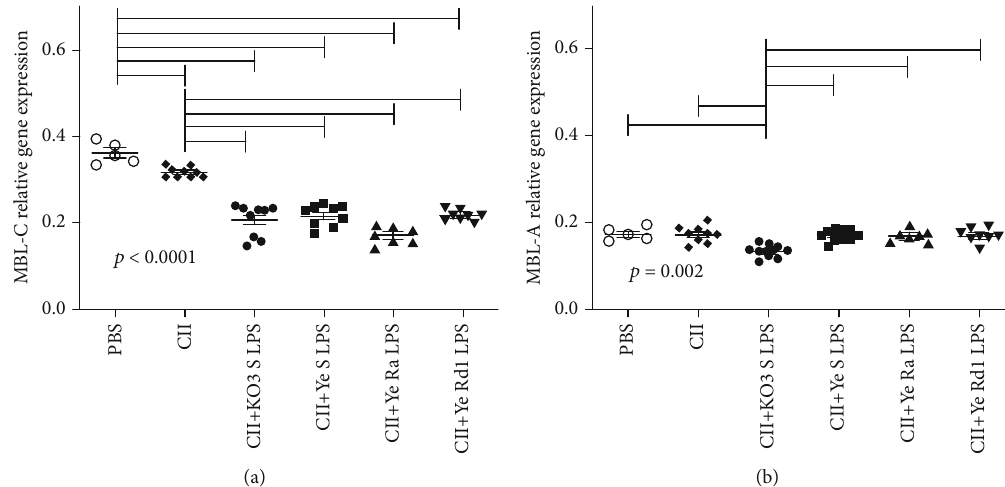
Figure 8: In fl uence of long-term immunization with CII and LPS on Mbl2 (MBL-C) and Mbl1 (MBL-A) gene expressions. The MBL-C (a) and MBL-A (b) relative gene expressions were determined in the livers of immunized mice. The results were analyzed with ANOVA Kruskal- Wallis with Dunn ’ s post hoc test. The individual values, mean, and SEM are presented. Horizontal lines show the statistically signi fi cant di ff erences between analyzed